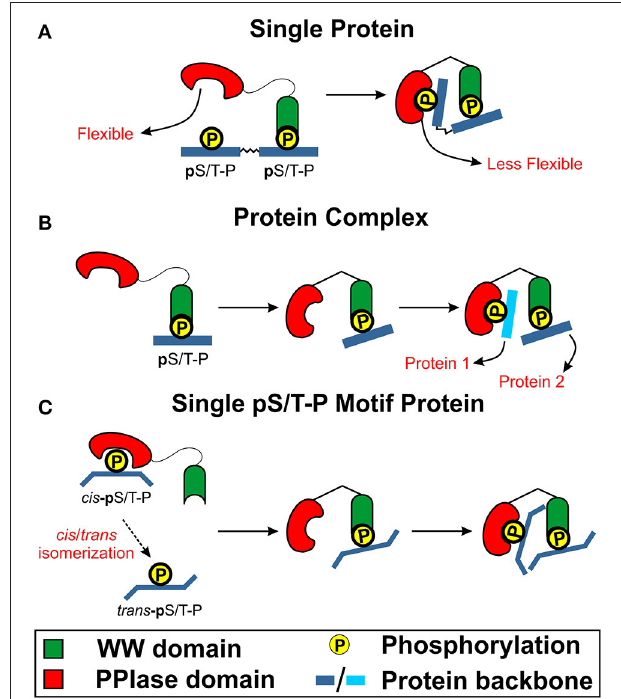
FIGURE 4 | The role of interdomain communication in Pin1 function. Based on recent findings, WW domain could be required for initial binding to initiate conformation changes to the PPIase domain for its binding and catalytic function. (A) WW domain binds first to pS/T-P motif that leads to interdomain communication to trigger conformation change (decreased flexibility) that lead to PPIase binding to a distal pS/T-P motif on the same protein to initiate catalytic function. (B) WW domain first binds to the pS/T-P motif to initiate interdomain communication to trigger PPIase domain conformation change